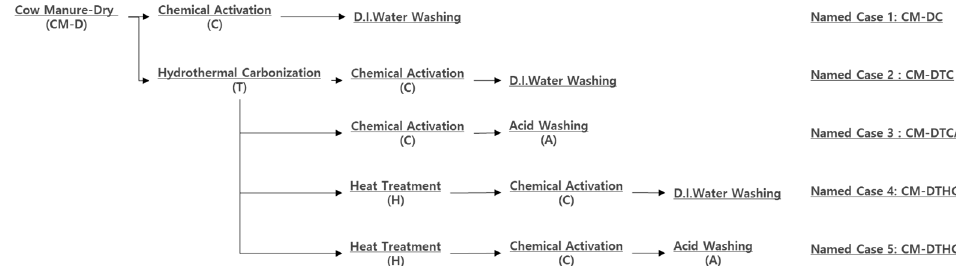
Figure 1. The various preparation methods (Hydrothermal carbonization, Heat treatment, Chemi- cal activation, Acid washing) for activated carbon-based cow manure. activation, Acid washing) for activated carbon-based cow